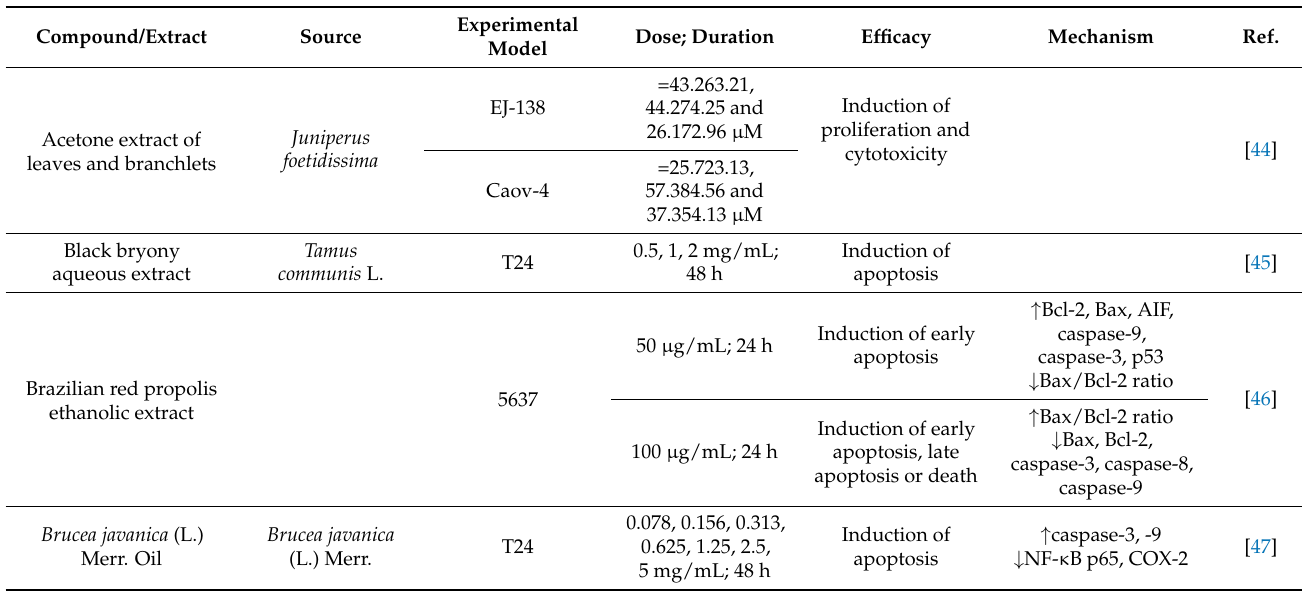
Table 2. Single extracts inducing apoptosis.